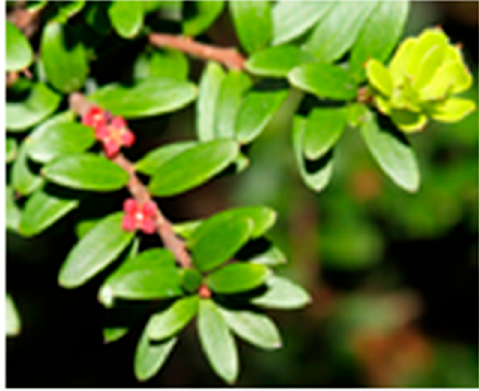
Figure 1. Photography of the Maythenus disticha shrub.